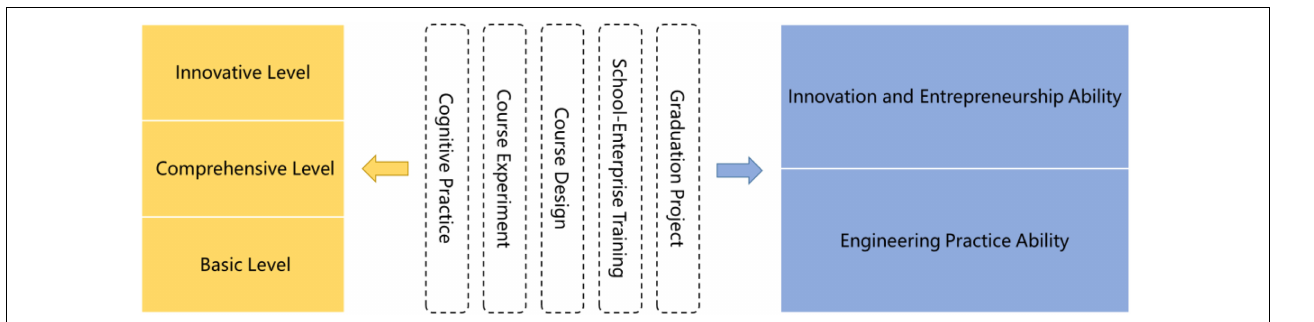
FIGURE 4 | “Three-level and Five-category” practice teaching